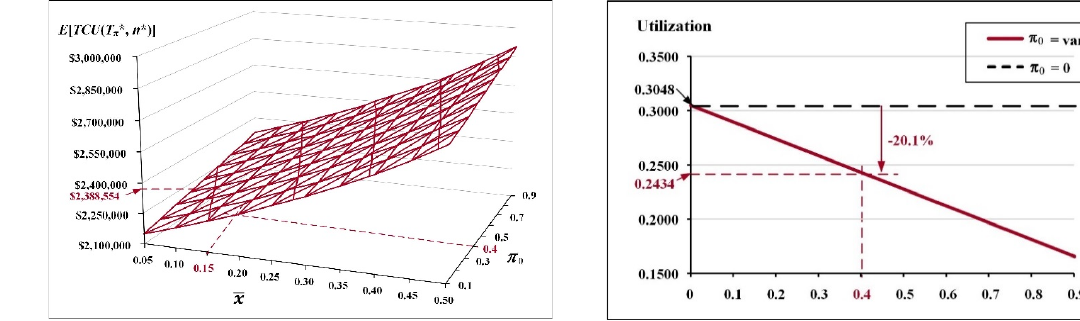
Fig. 11. The impact of subcontracting portion π 0 on the system’s utilization